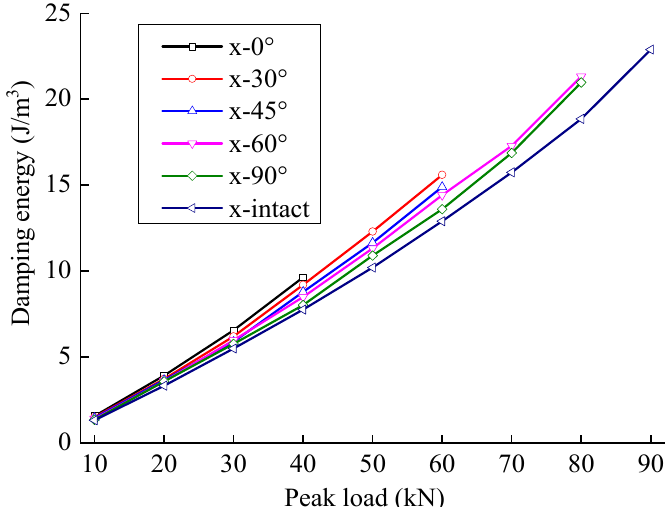
Figure 13. Damping energy evolution curve of sandstone with different crack angles.